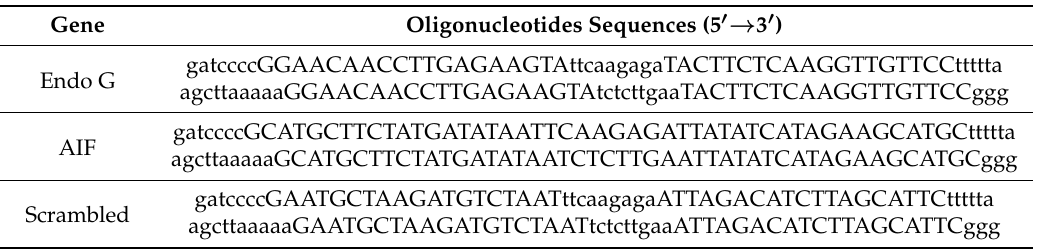
Table 1. Short-hairpin knockdown RNA (shRNA) primer